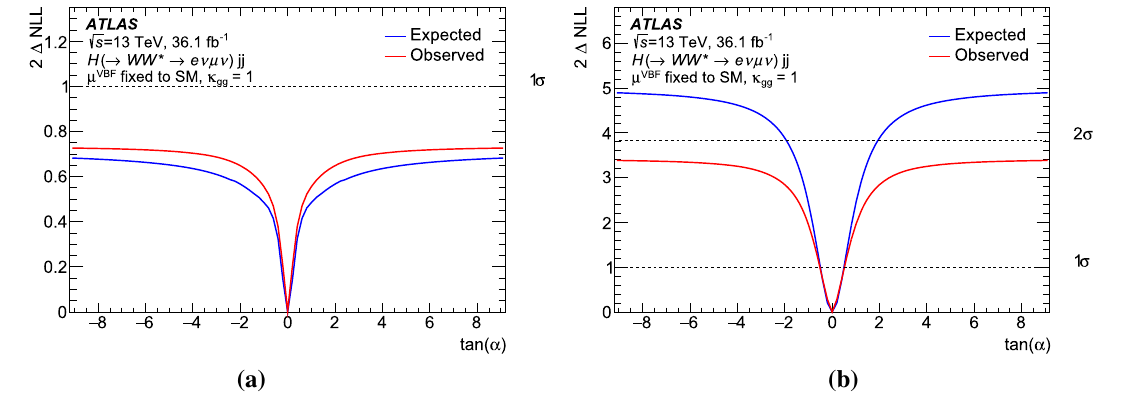
Fig. 5 Expected and observed likelihood curves for scans a over tan (α) where only the shape is taken into account in the fit, and b over tan (α) when both shape and normalisation are used